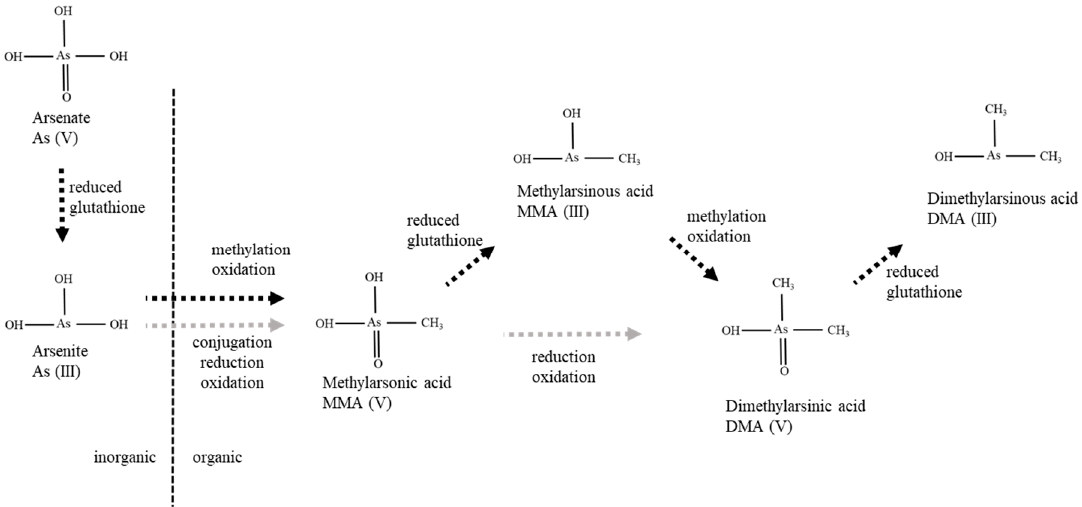
Figure 1. Proposed metabolic pathways for the conversion of inorganic Aresenic (As) into organic As. The mechanism involved in the oxidation and reduction of As is shown.